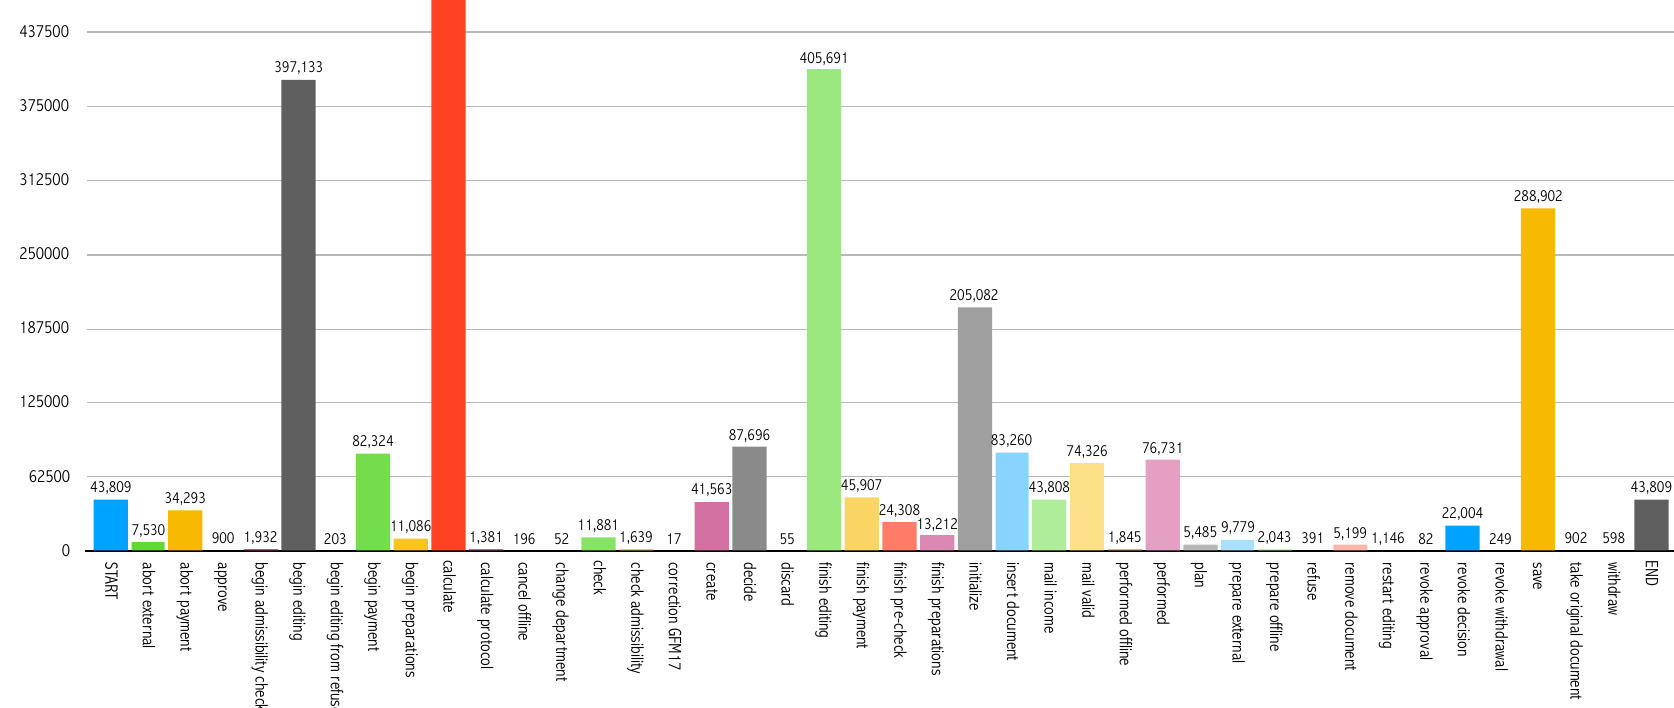
Figure 10. Activities and their enacted